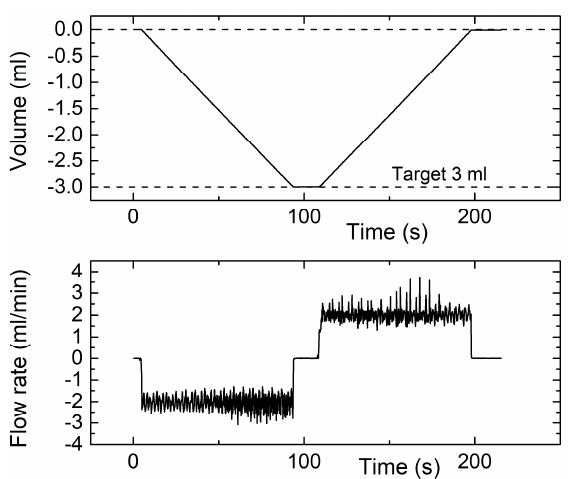
Figure 10. Instantaneous measured volume ( top ) and flow rate ( bottom ) for a measurement cycle obtained by programming the syringe pump for a 3 mL volume and 2 mL/min flow rate.